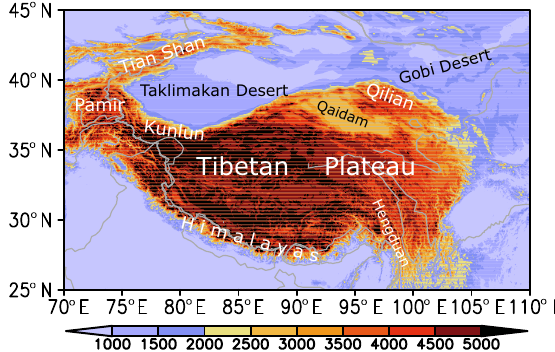
Figure 1. Terrain of the Tibetan Plateau (unit: m) including major mountains (Kunlun, Himalayas, Hengduan, Qilian and Tian Shan), Pamir Plateau, Qaidam Basin deserts and its surrounding deserts (Taklimakan and Gobi